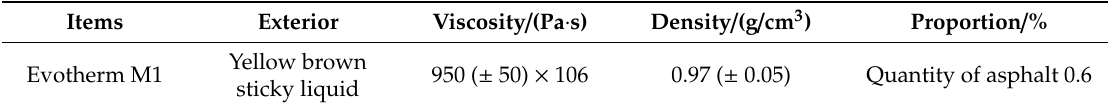
Table 2. Properties of warm mix